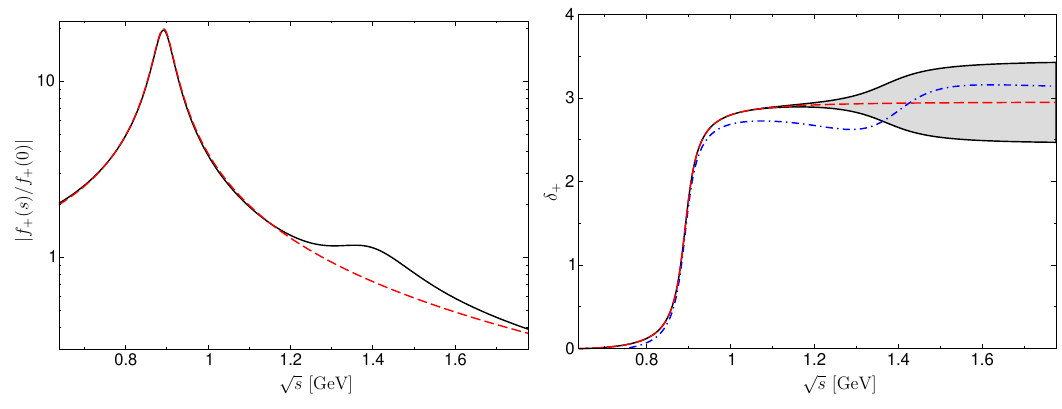
Figure 1: Left: | f + ( s ) / f + ( 0 ) | from [ 11 ] (black solid line) in comparison to the Omnès factor (10) (red dashed line). Right: δ + from a Breit–Wigner approximation for the K ∗ ( 892 ) (red dashed line) in comparison to the phase from the experimental fit [ 11 ] (blue dot-dashed line). The gray band gives our estimate of inelastic